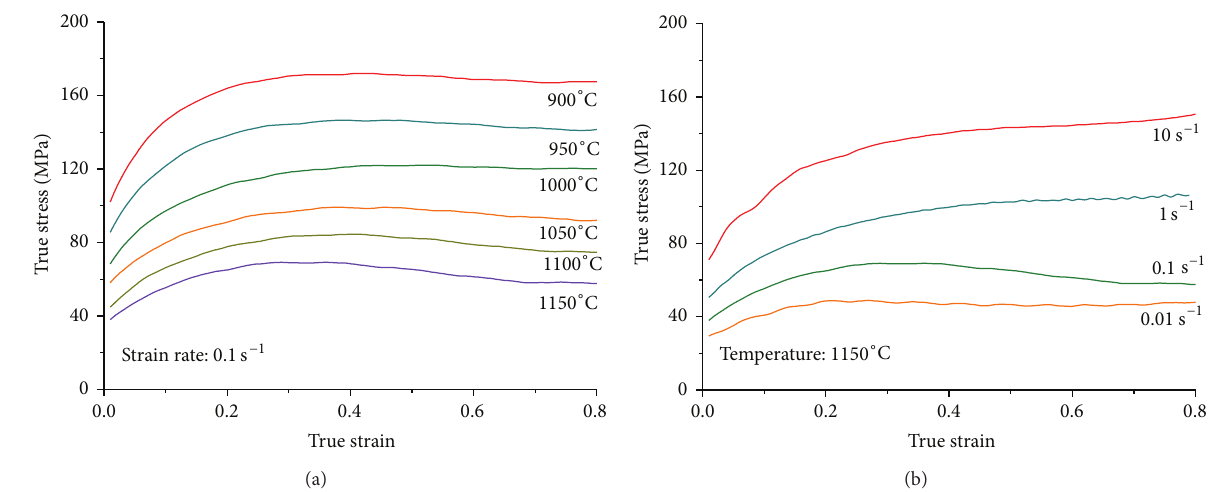
Figure 2: Typical true stress-strain curves for X20Cr13 martensitic stainless steel under different deformation conditions.